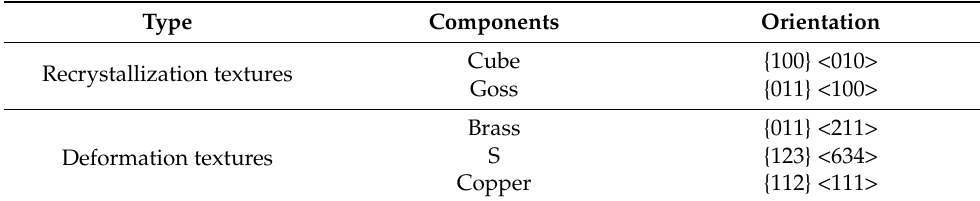
Table 2. List of texture components for cold-rolled samples.